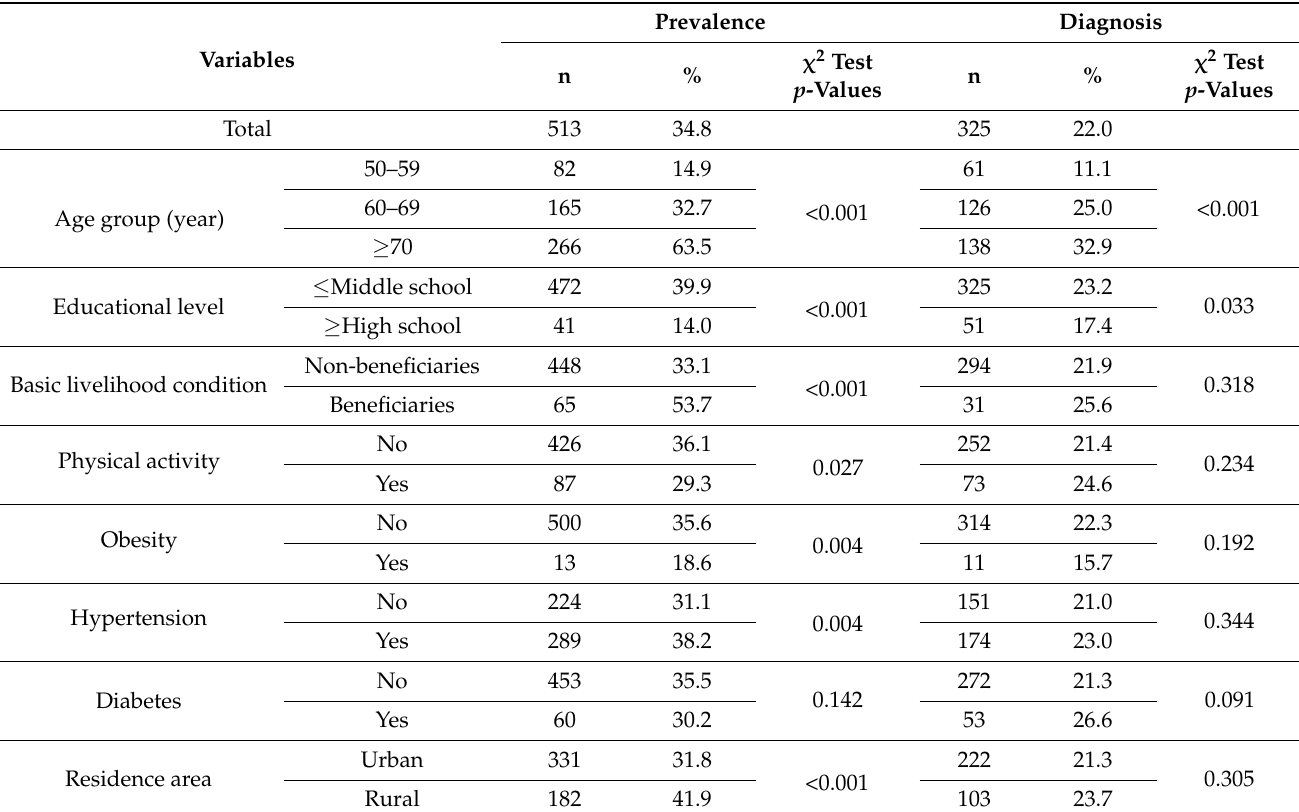
Table 2. Osteoporosis prevalence and diagnosis rates according to factors.